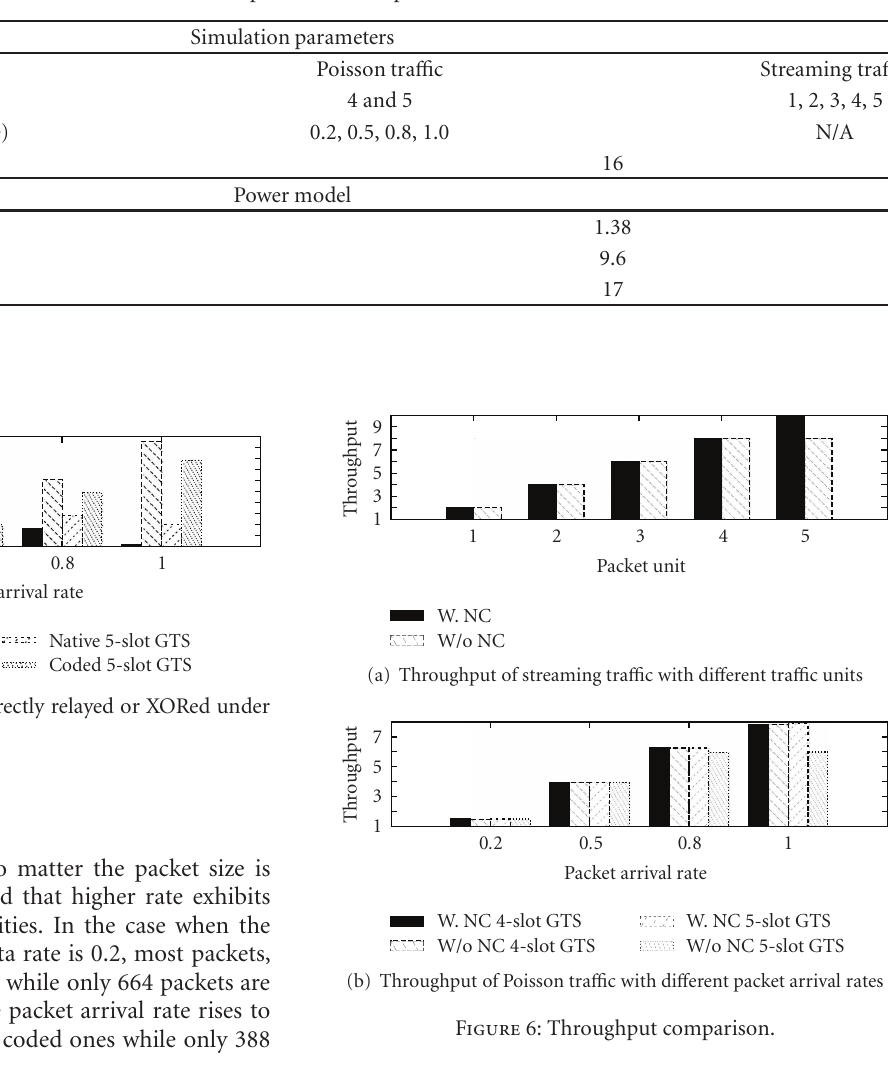
Table 2: Simulation parameters and power model.